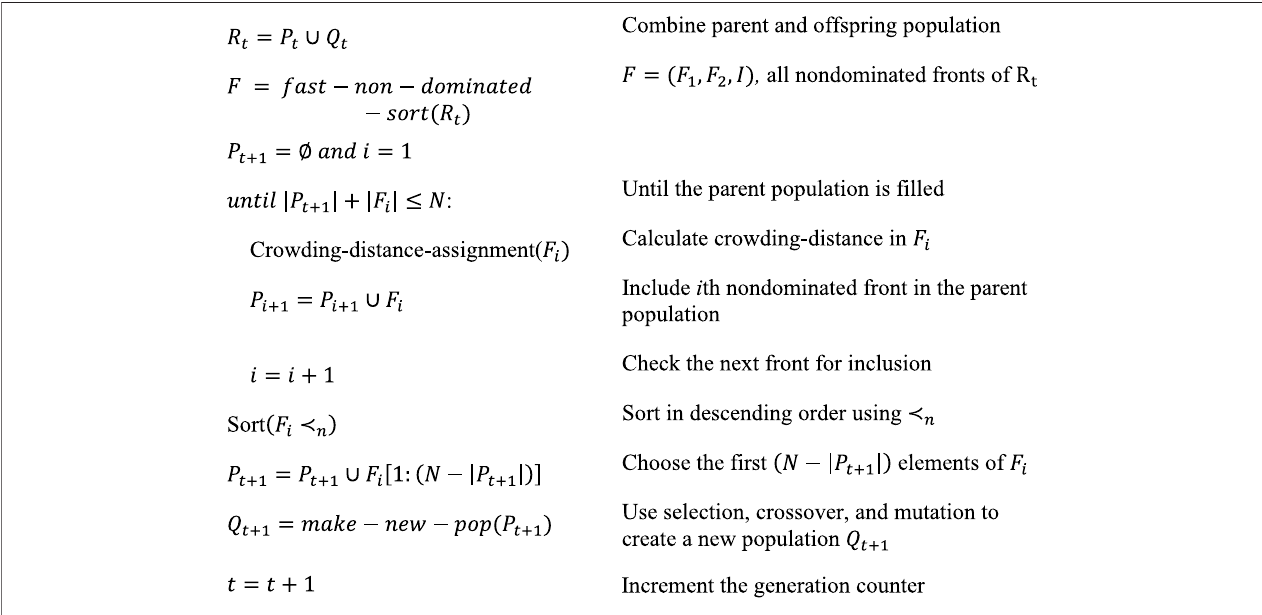
FIGURE 3 | The Non-Dominated Sorting Genetic Algorithm-II (Deb et al., 2002).